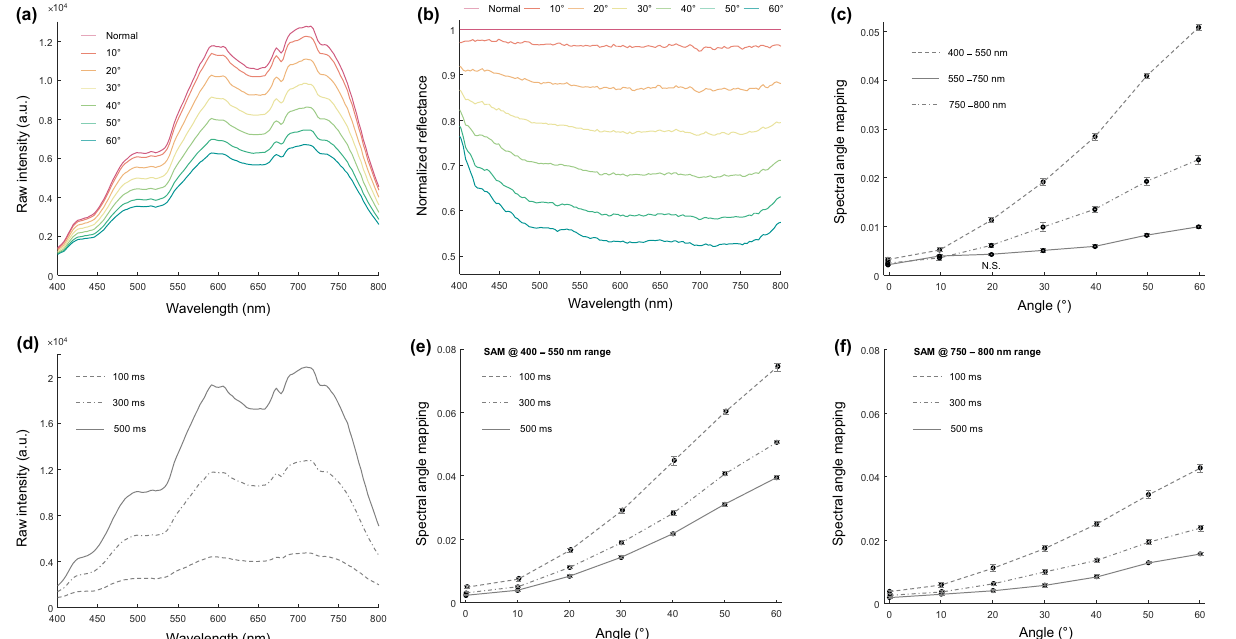
Figure 2. Quantitative analysis of spectral profiles of the light source measured at various angles. ( a ) Raw spectral profiles of the light source were measured via the spectrometer with an exposure time of 300 ms. ( b ) Spectral profiles were normalized by exploiting the spectral signal obtained at the normal angle as a reference signal. ( c ) SAM results of three spectral regions, 400–550 nm (dot-dash line), 550–750 nm (solid line), and 750–800 nm (dashed line). ( d ) Average reflected signals of the light source measured at the normal position with an exposure time of 100 ms (dashed line), 300 ms (dot-dash line), and 500 ms (solid line). ( e , f ) SAM results of 400–550 nm and 750–800 nm,